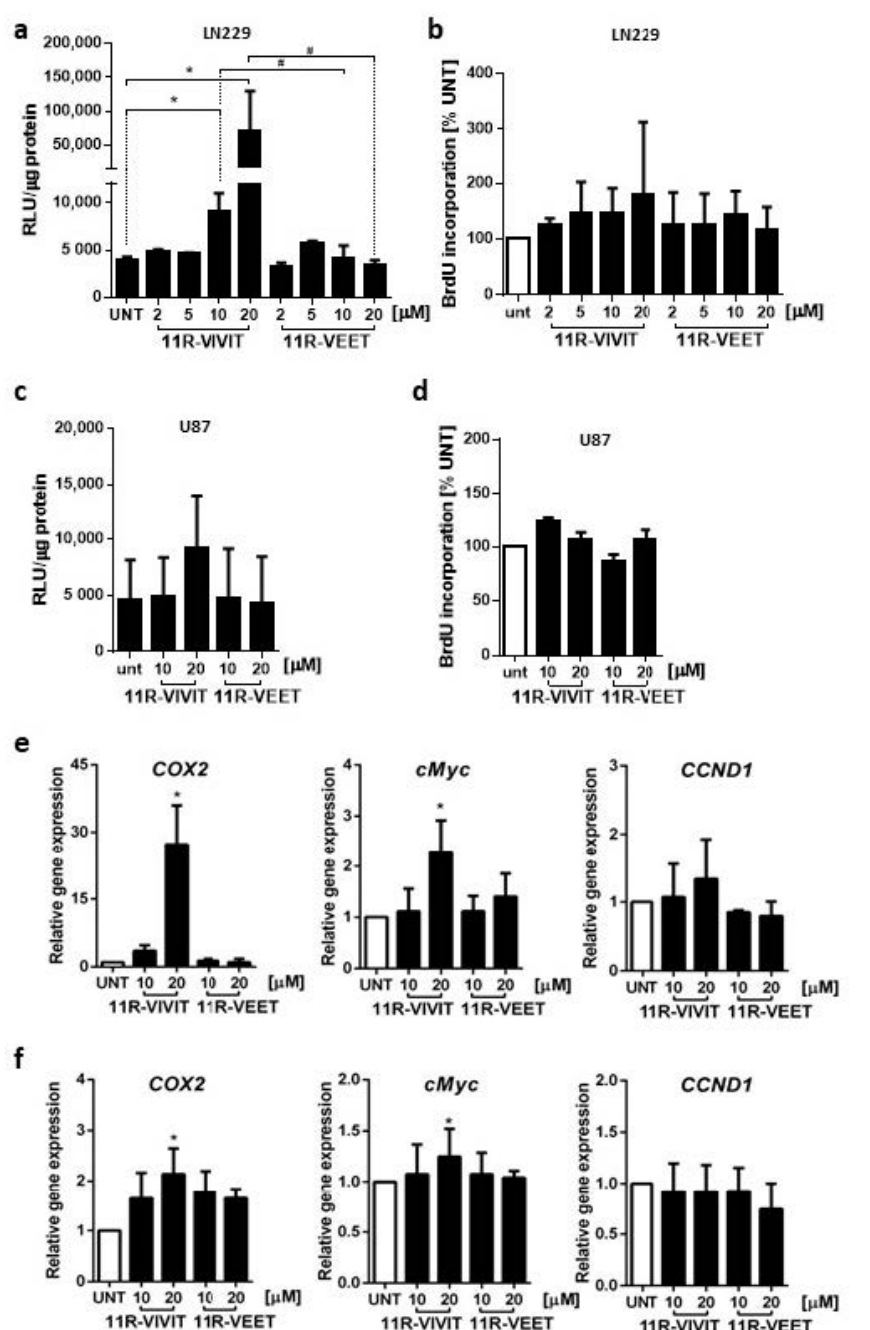
Figure 4. The effect of 11R-VIVIT on NFAT activity and proliferation of glioma cells. NFAT-dependent promoter activity was measured using luciferase reporter assay in LN229 ( a ) and U87 ( c ) cells transfected with pGL3-3xNFAT-luc plasmid and treated for 25 h with the peptide at indicated concentrations (including 1 h pre-treatment prior to transfection). Bars represent means ± SD from at least 3 experiments carried out in duplicates. Statistical significance of changes vs. untreated cells (UNT) or 11R-VEET-treated cells was determined using one-way ANOVA followed by Tukey post-hoc test for multiple comparisons (* p < 0.05 vs. UNT, # p < 0.05 vs. 11R-VEET). The proliferation of LN229 ( b ) and U87 ( d ) cells was evaluated after 48 h treatment with the peptides at the indicated concentrations. mRNA levels of endogenous NFAT target genes were analyzed by qPCR in LN229 ( e ) and U87 ( f ) cells after 6 h of treatment. Statistical significance of changes vs. untreated cells (UNT) was determined using one sample t -test (* p <